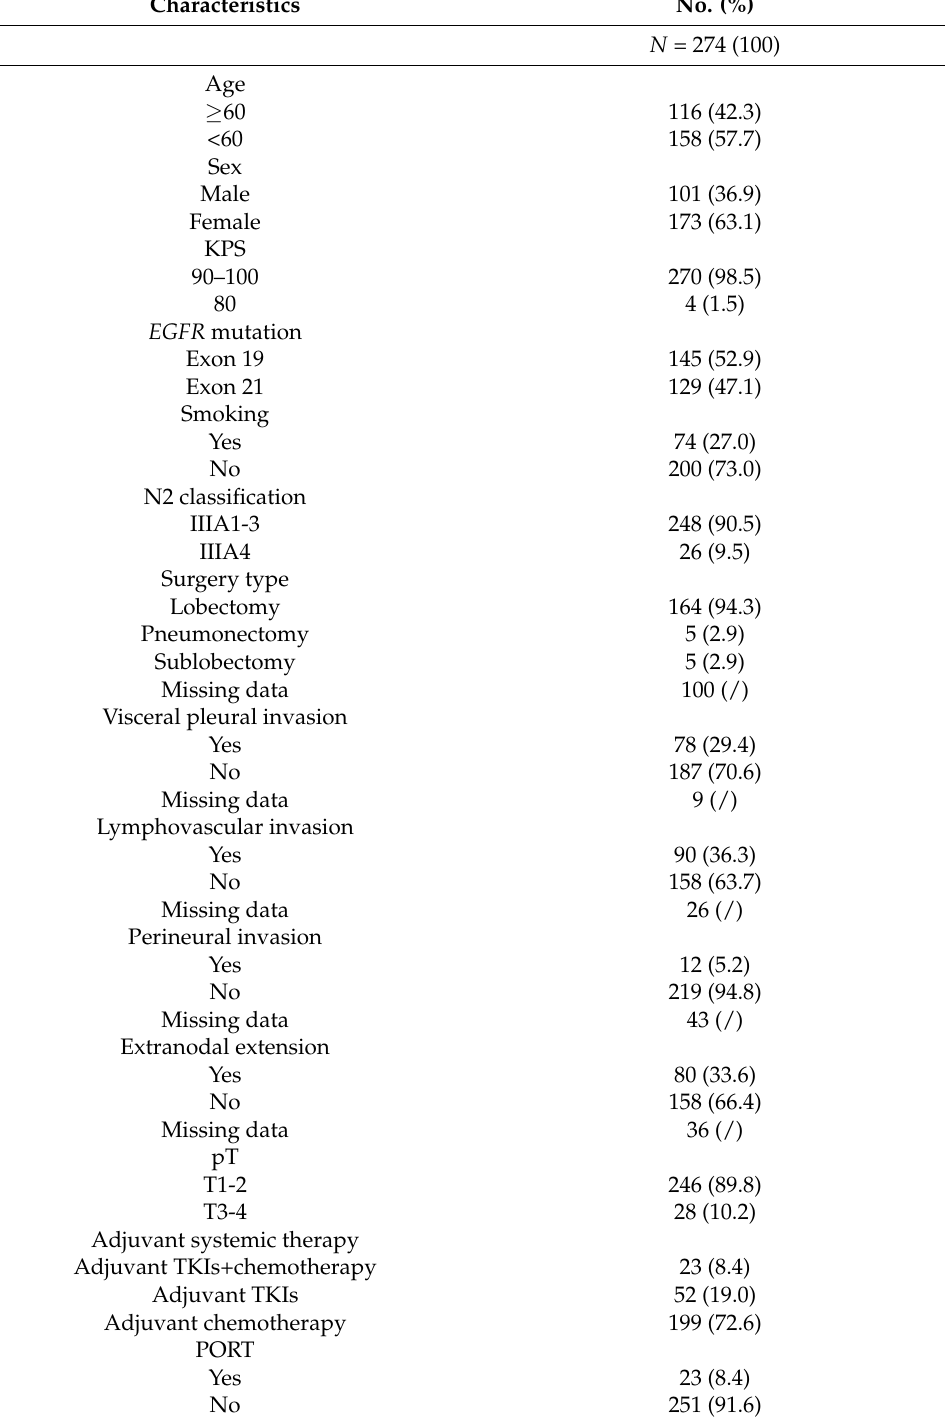
Table 1. Patient